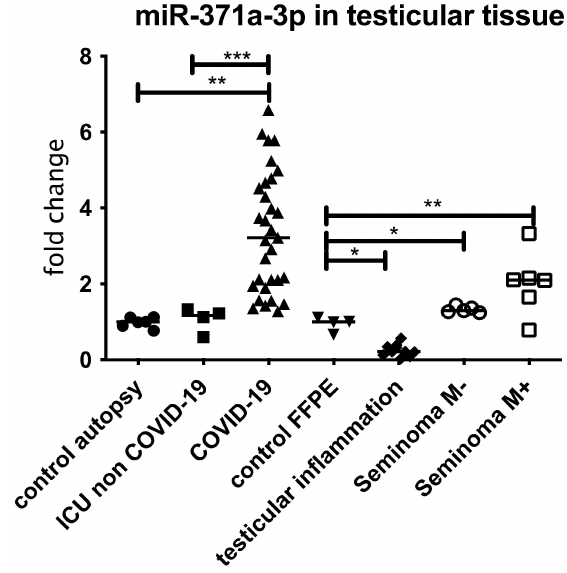
Figure 3. miR 371a-3p in FFPE testicular tissue samples from COVID-19 patients compared to patients with ICU/ECMO, inflamed testis and Seminoma patients without metastasis (M − ) or with metastasis (M+). All samples were normalized to 5s rRNA and corresponding controls (for COVID-19 and ICU controls from autopsy patients and for inflamed testis and Seminoma controls from testicular surgery without inflammatory disease or tumor). An increased expression, comparable with the miR expression of Seminoma patients with metastasis was detectable. In case of ICU non COVID-19, Seminoma without metastasis and inflamed, a significant reduction compared to COVID-19 was